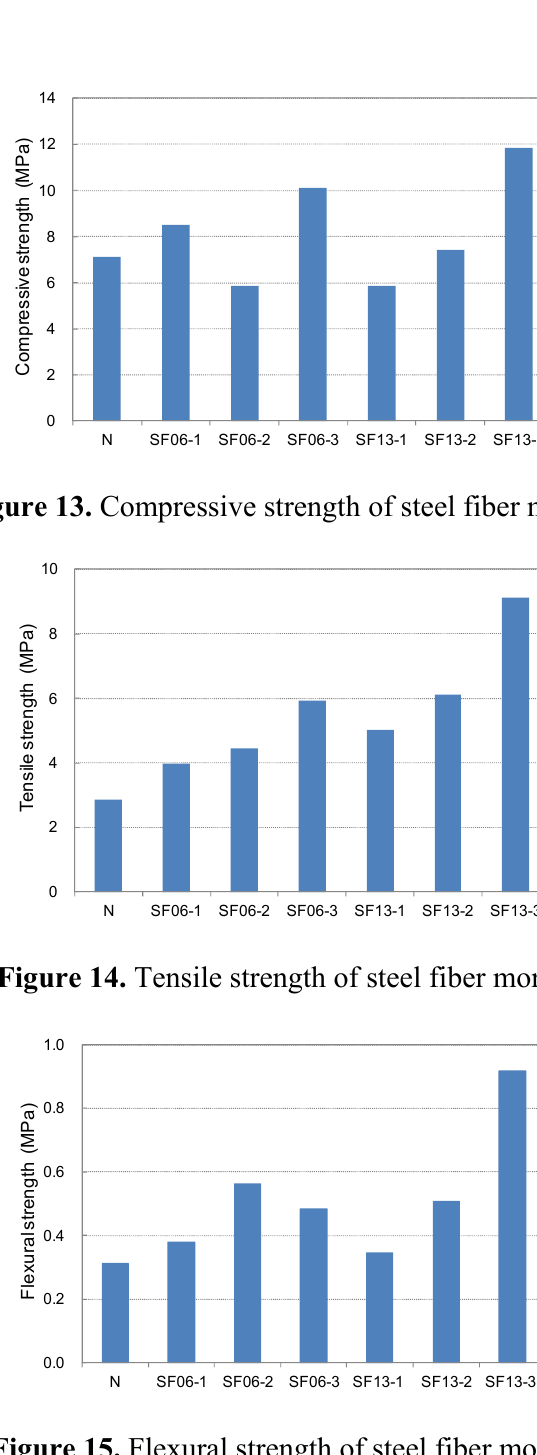
Figure 15. Flexural strength of steel fiber mortar.